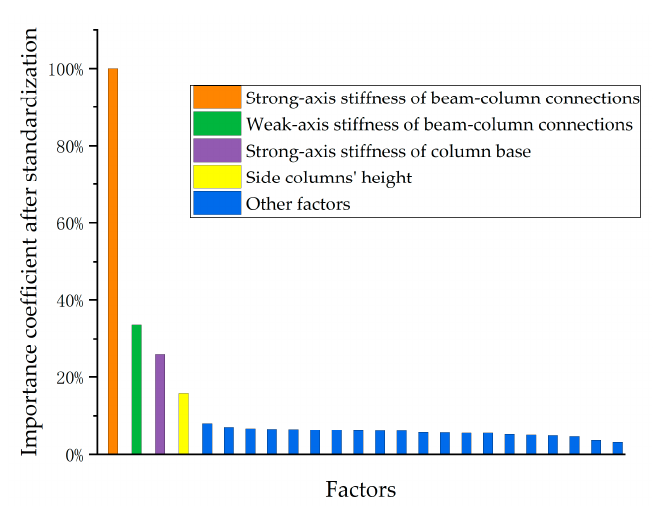
Figure 15. Importance coefficient after standardization.